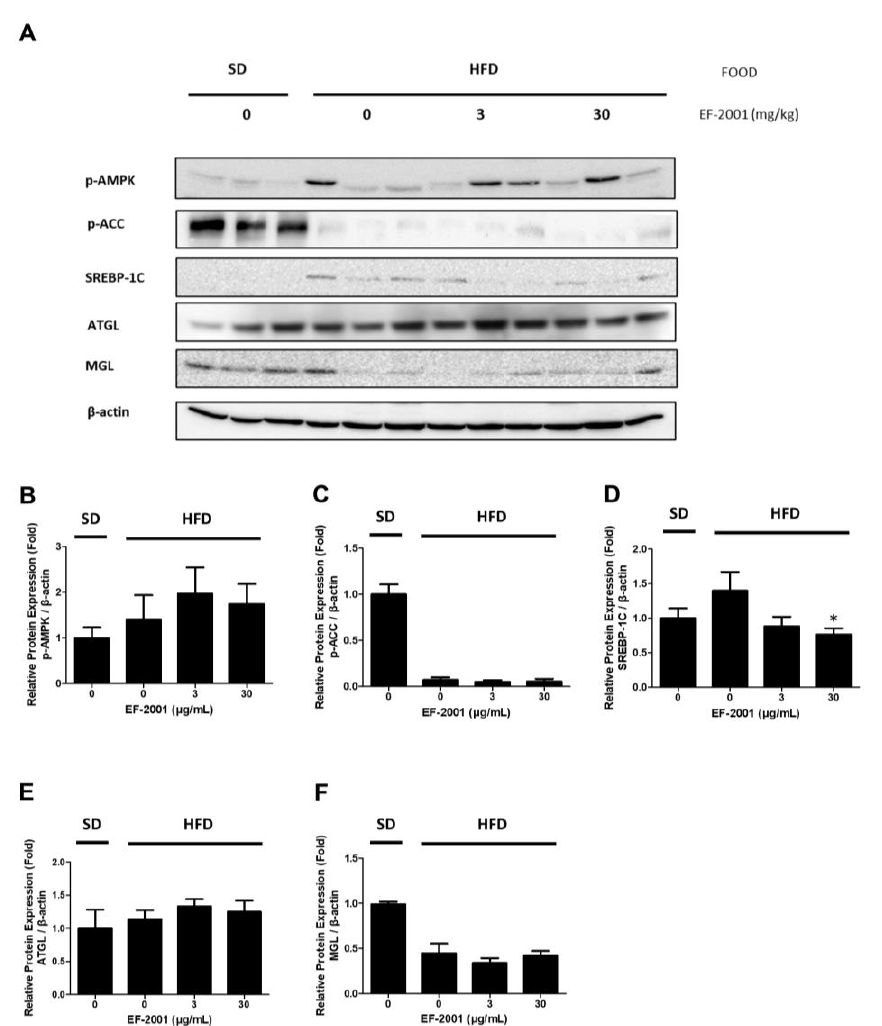
Figure 8. Effects of EF-2001 on lipase and AMPK signaling pathways in HFD-induced fatty liver. Male rats were divided into SD or HFD groups and orally administered refined water, 3 mg/kg or 30 mg/kg EF-2001 for 6 weeks ( n = 6 rats/group). Lipase and AMPK signaling pathway were detected by immunoblotting. ( A ) The protein levels of p-AMPK, SREBP-1C, p-ACC, ATGL, and MGL were standardized depending to the amount of β -actin. The relative protein expression levels of p-AMPK ( B ), SREBP-1C ( C ), p-ACC ( D ), ATGL ( E ), and MGL ( F ) are shown in the graphs. Data are represented as the mean ± SEM. ( n = 6); * p < 0.05 vs. HFD-fed rats alone without EF-2001.